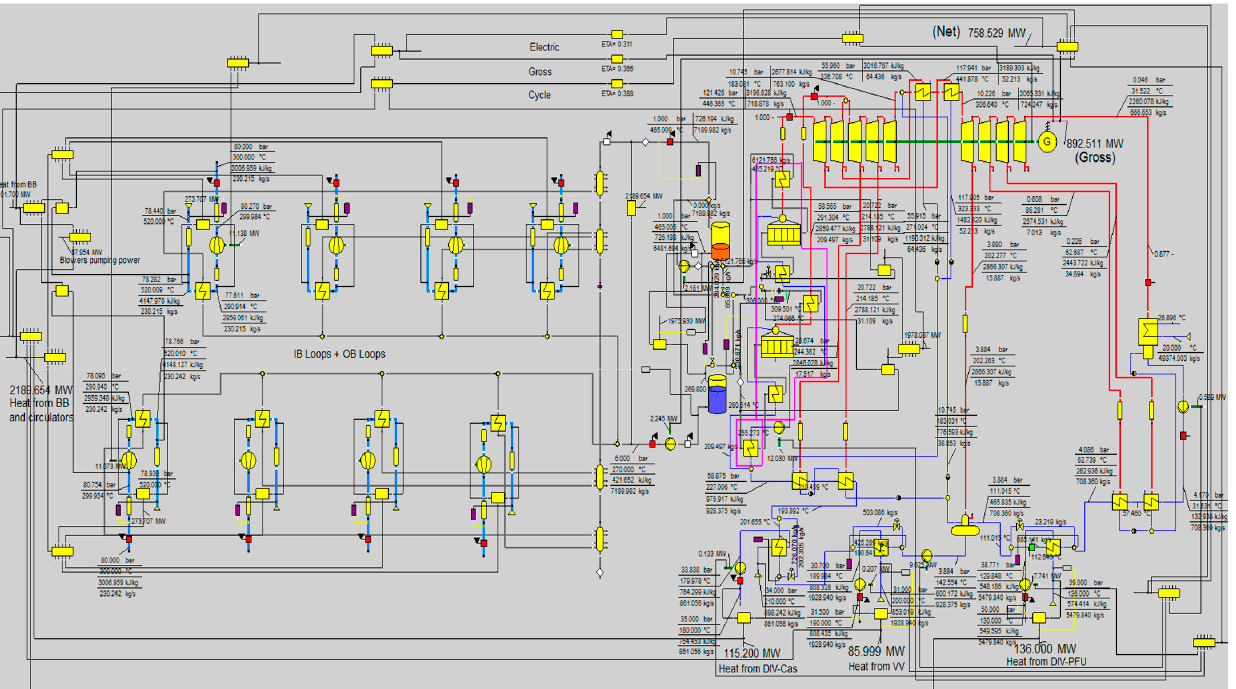
Figure 3. DEMO HCPB BOP ICD with optimized PCS and 90% power output during pulse and dwell.